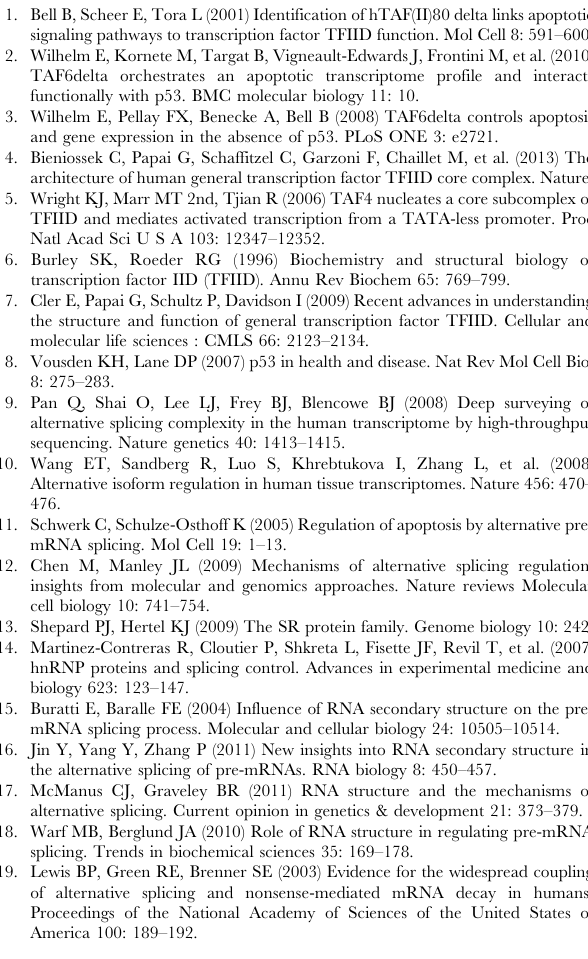
Figure S5 Schematic representation of mutations used in this study. (A) The TAF6 minigene construct is shown schematically. (B) A nucleotide resolution list of mutations (altered nucleotides shown in red) from different regions of the minigene are illustrated. Black text corresponds to wild type sequences and the exons 2 and 3 (white boxes), alternative exon 2a (grey box) and intron 2 (black line) are indicated above the sequences. Figure S6 Mapping of the branchpoint in intron 2 of the TAF6 minigene. (A) A TAF6 minigene construct bearing a point mutation in a putative branchpoint (adenine 156 to guanosine) was transfected into HeLa cells for splicing analysis as in Figure 3.